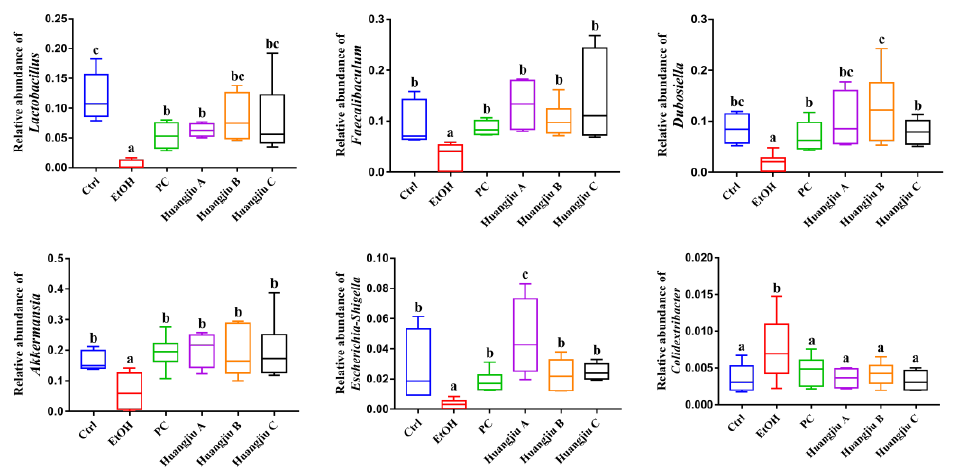
Figure 6. The relative abundance of gut microbial community members at the genus level. Values presented as mean ± standard deviation (SD) ( n = 8). Different lowercase letters indicate statistically significant differences ( p < 0.05) between the groups using one-way ANOVA followed by Fisher’s LSD test.